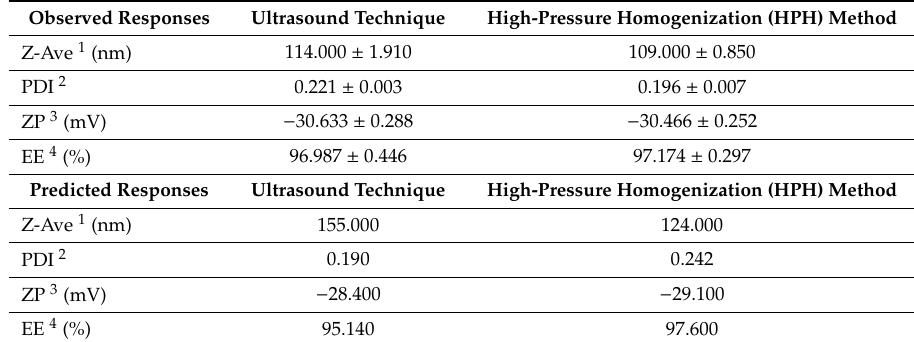
Table 5. Observed and predicted response values of the two optimized rivastigmine-loaded nanostructured lipid carriers (NLC)